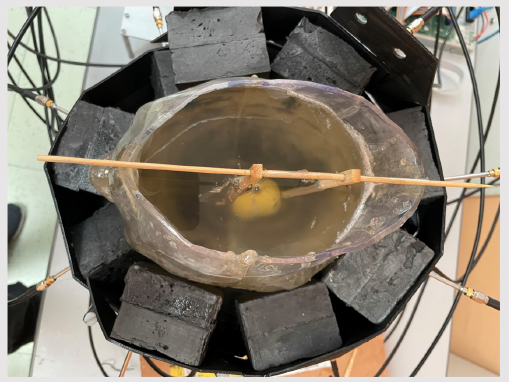
Figure 2. Homogeneous phantom (HP) with immersed stroke target and supporting wooden